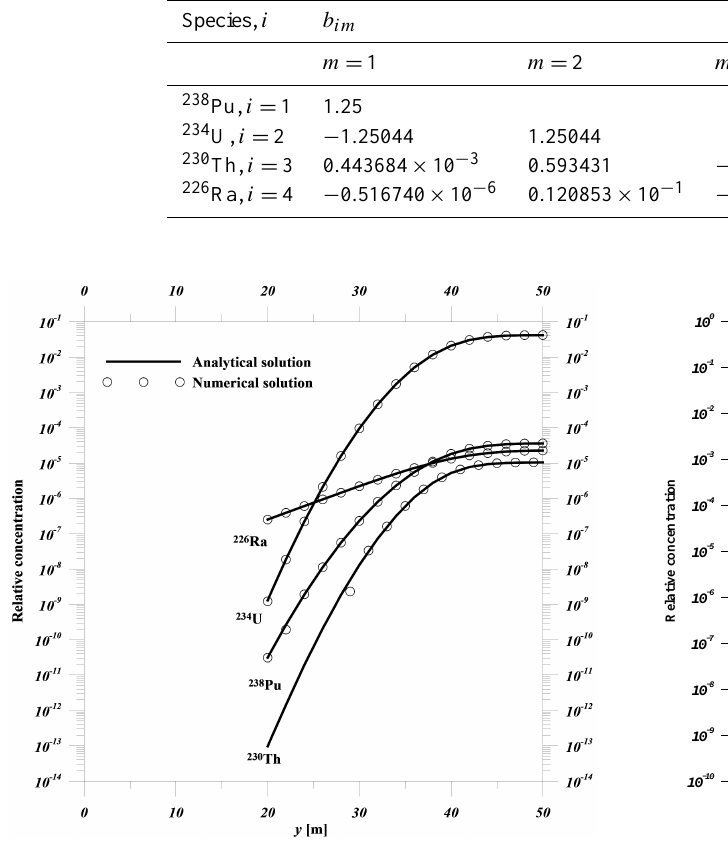
Fig. 5 Figure 5. Comparison of spatial concentration profiles of four species along the longitudinal direction ( = 50m) at t = 1000years obtained from derived analytical solutions and numerical solutions for convergence test example 2 of four-member radionuclide decay chain 238 Pu → 234 U → 230 Th → 226